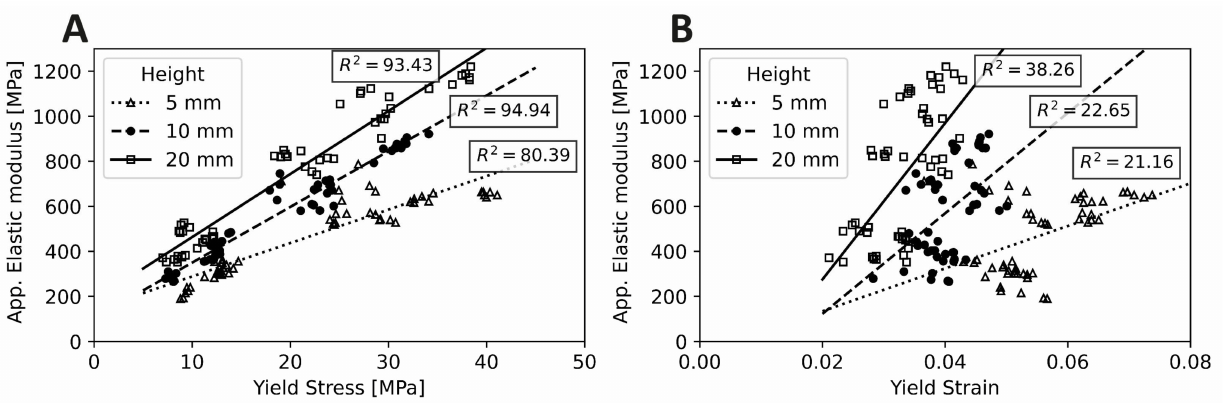
Figure 6. Correlation between mechanical properties of the scaffold test specimens: ( A ) Yield Stress with respect to Apparent Elastic modulus and ( B ) Yield Strain with respect to Apparent Elastic modulus. Lines represent a linear fit with R 2 (%) being the coefficient of